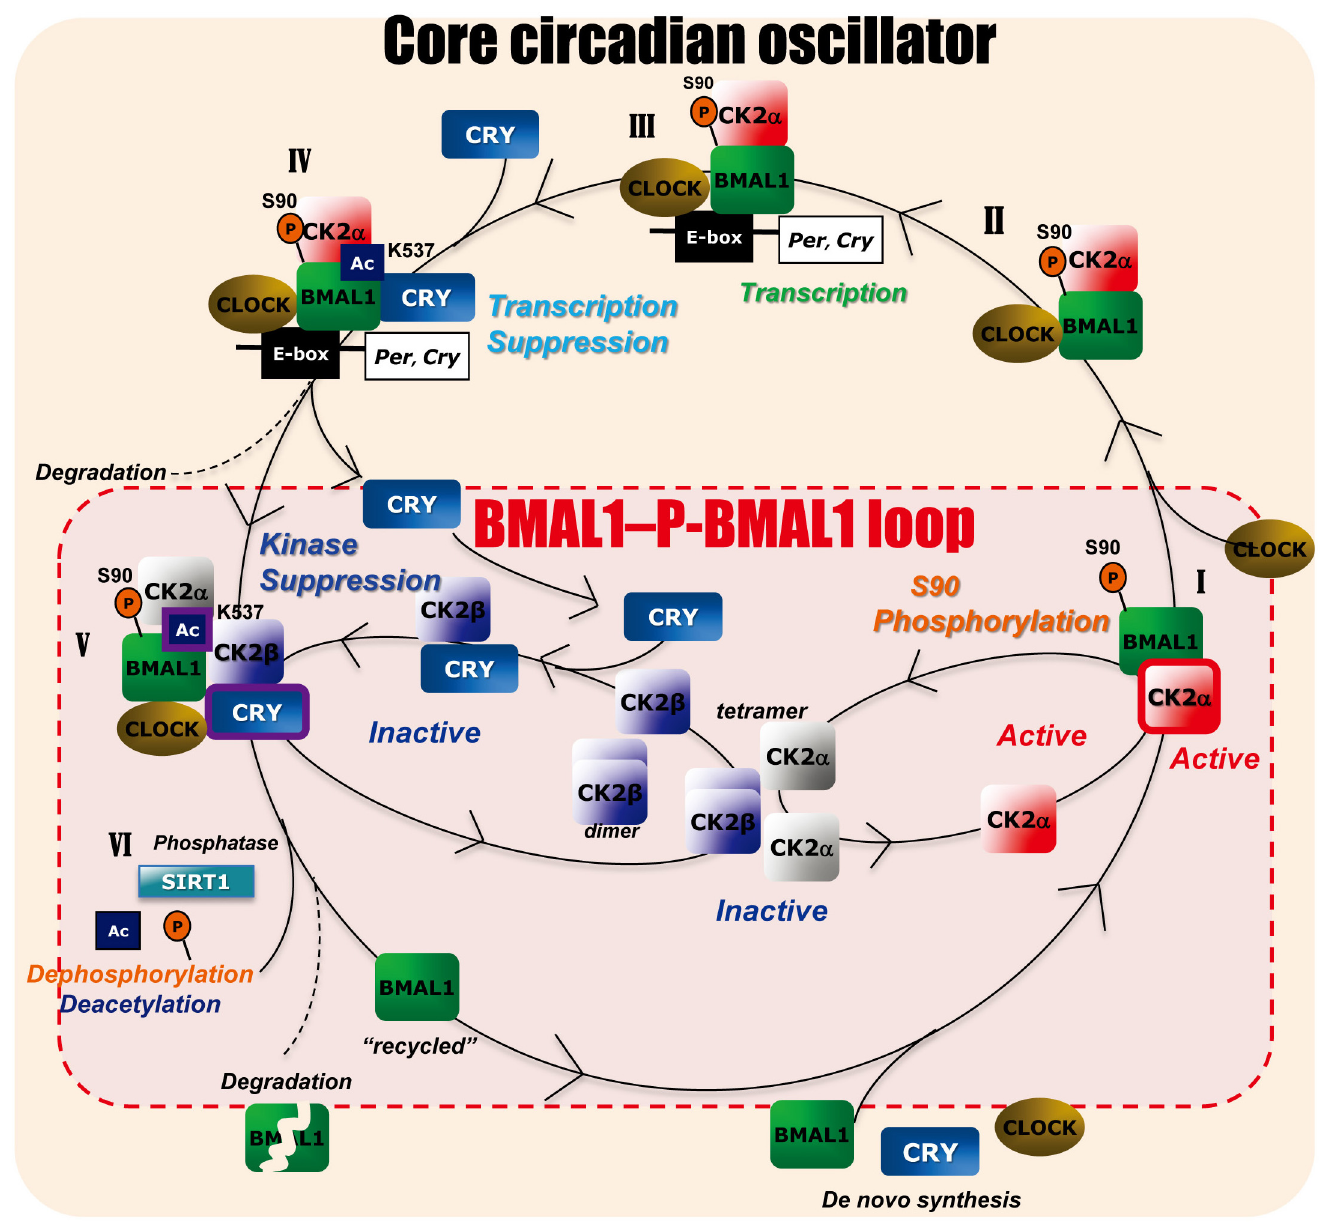
Fig 8. A CRY-based dual negative feedback model integrating the BMAL1 – P-BMAL1 loop with the circadian core oscillator. Proposed model for CRY-CK2 β – mediated circadian rhythms in BMAL1 phosphorylation by CK2 α (the BMAL1 – P-BMAL1 loop) as an integral part of the circadian core oscillator. In short, upon phosphorylation of BMAL1-S90 by CK2 α ( step I ), BMAL1 binds to CLOCK ( step II ) to form a transcriptional activator complex for transcription of E-box promoter containing clock genes (i.e., Cry and Per genes) and clock-controlled genes ( step III ). CK2 α remains bound to BMAL1 in a catalytically active state (as indicated by the red color). After a delay, CRY proteins will bind to the CLOCK – BMAL1 – CK2 α complex to inhibit E-box gene transcription ( step IV ). Upon dissociation of the BMAL1 – CLOCK – CRY – CK2 α complex from the DNA, CRY is released from the complex to allow CRY – CK2 β binding, and subsequent BMAL1 – CK2 β binding, resulting in the formation of BMAL1 – CLOCK – CRY – CK2 β – CK2 α complex ( step V ). This step, triggered by acetylation of BMAL-K537, renders CK2 α inactive (as indicated by the grey color). After dissociation of the BMAL1 – CLOCK – CRY – CK2 β – CK2 α complex, BMAL1